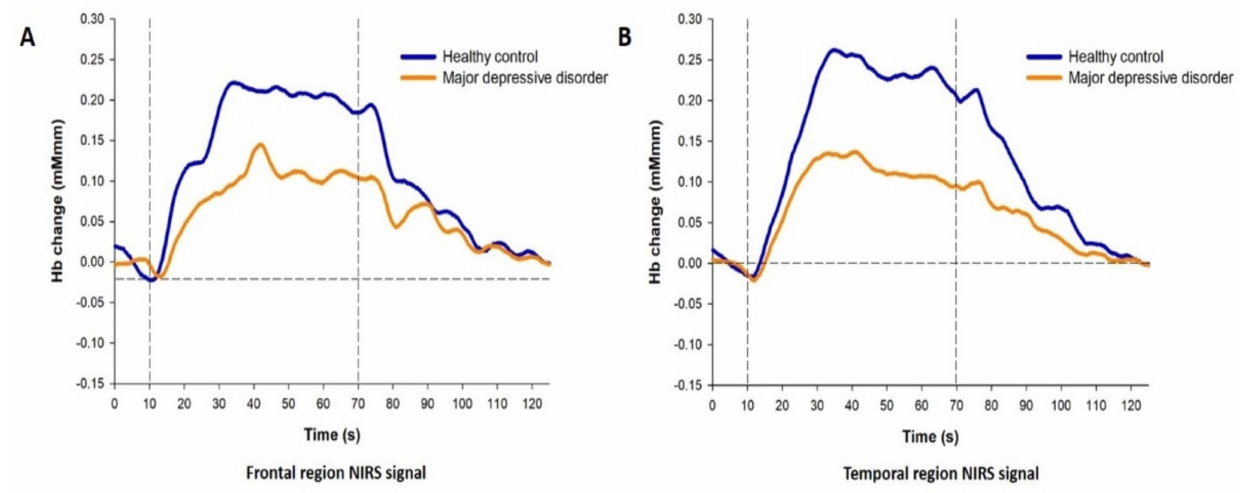
Figure 3. Average oxy-haemmoglobin waveforms in the ( A ) frontal and ( B ) temporal